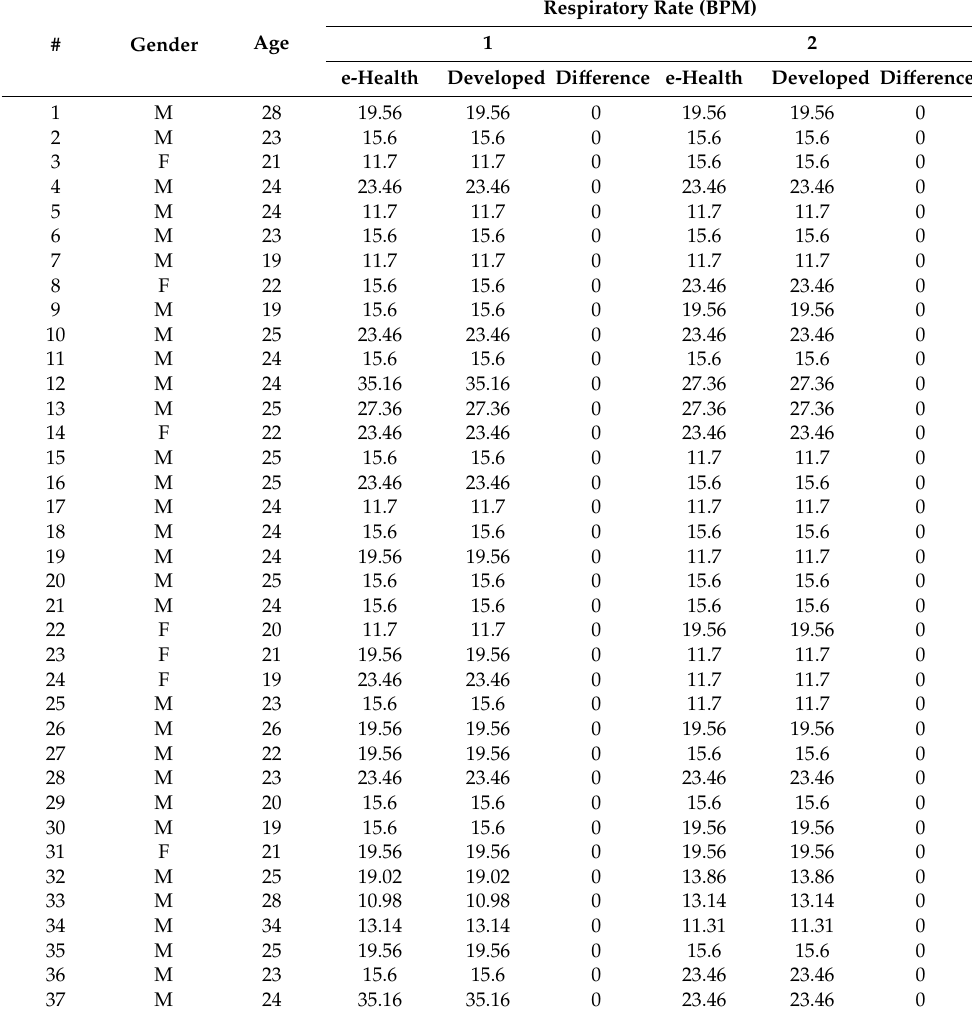
Table A1. The measured and actual respiratory rate of thirty-seven adults while